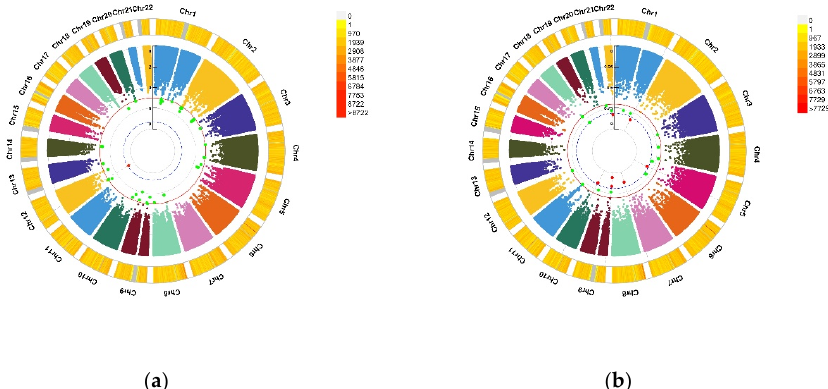
Figure 1. Genomic regions interacting with blood VD for the PHQ score and the GAD score. ( a ) Depression (PHQ score), A SNP allele was found to significantly interact with blood VD in depression (PHQ score); ( b ) Anxiety (GAD score), seven independent SNP alleles were found to significantly interact with blood VD in anxiety disorder (GAD score). From the center, the first circos depicts the −log10 p -values of each variant due to double exposure, i.e., the effect of both SNP allele and blood VD. The second circos shows chromosome density. Red dots represent the p < 5 × 10 −8 and green dots represent p < 1 × 10 −7 . The figure was generated using the “CMplot” R script (https://github.com/YinLiLin/R-CMplot) (accessed on 15 February 2021).